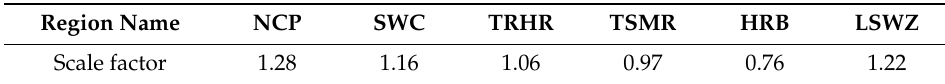
Table 1. Filtering scale factor calculated using the single-scale factor method in the six study regions in China.